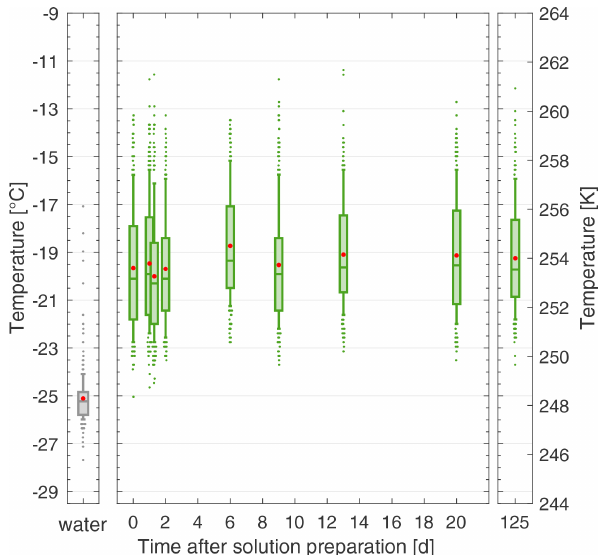
Figure 7. The solution stability of a 20mgCL − 1 lignin solution (batch 2) over 125d, stored in the fridge in the dark. Each box plot represents the frozen temperatures of 288 wells; the middle line is the median ( T 50 ), the outer edges of the box are the 25th and 75th percentiles, the whiskers extend to the 10th and 90th percentiles, and the red dot is the mean. The water box plot represents the back- ground water solution. Duplicates were taken on day 1 (overlapping box plots). All temperature measurements have an uncertainty of ± 0.5 ◦